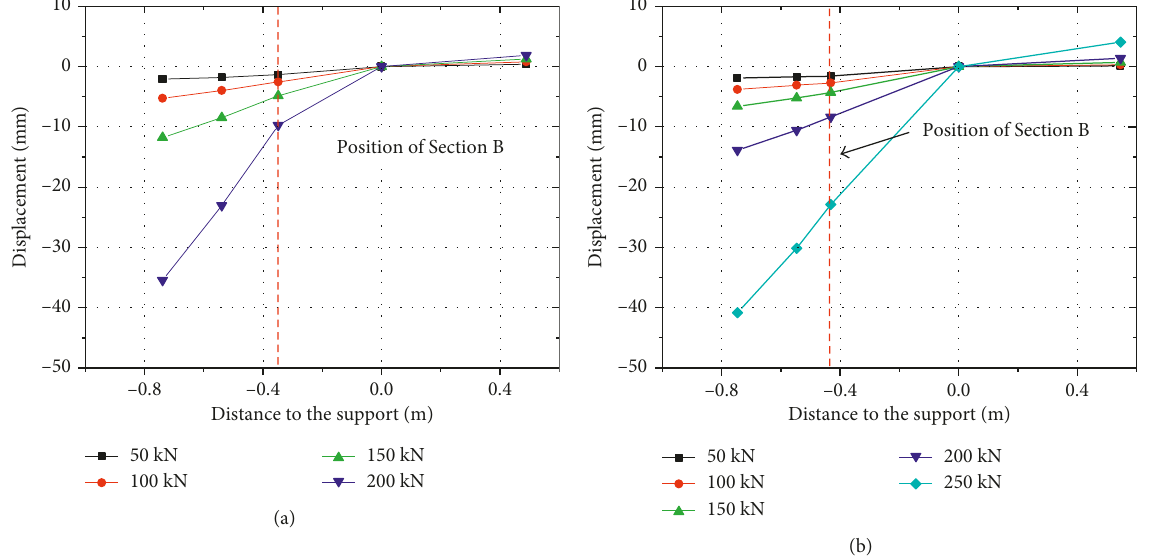
Figure 22: Deflection along the longitudinal direction of the